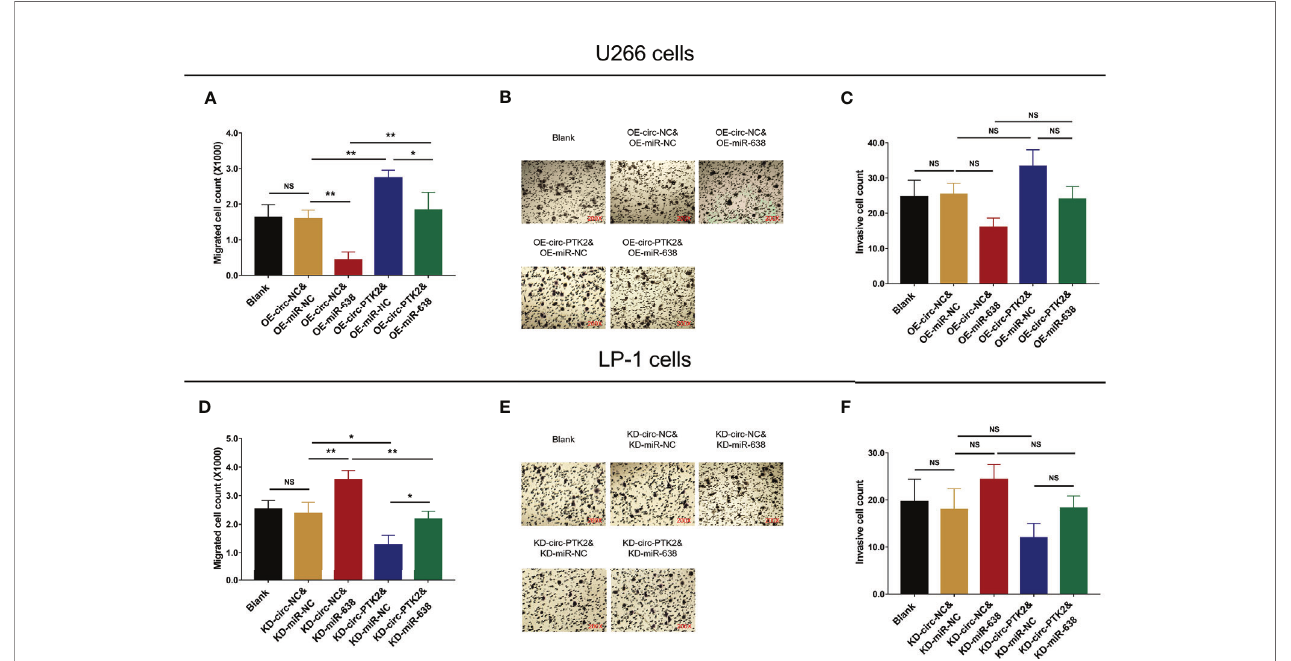
FIGURE 7 | Circ-PTK2 affected cell migration via regulating miR-638. Comparison of cell migration (A) and invasion (B, C) detected by Transwell migration and invasion assays among different groups of U266 cells. Comparison of cell migration (D) and invasion (E, F) detected by Transwell migration and invasion assays among different groups of LP-1 cells. Circ-PTK2, circular RNA protein tyrosine kinase 2; miR-638, micro RNA 638; NS, non-signi fi cant; OE-circ-NC, circRNA control overexpression; OE-circ-PTK2, circ-PTK2 overexpression; KD-circ-NC, circRNA control knock-down; KD-circ-PTK2, circ-PTK2 knock-down; OE-miR-NC, miRNA control overexpression; OE-miR-638, miR-638 overexpression; KD-miR-NC, miRNA control knock-down; KD-miR-638, miR-638 knock-down plasmid; * P <0.05; ** P < 0.01. Experiments were performed in triplicates. The comparison was determined by One-way ANOVA followed by Tukey ’ s multiple comparison